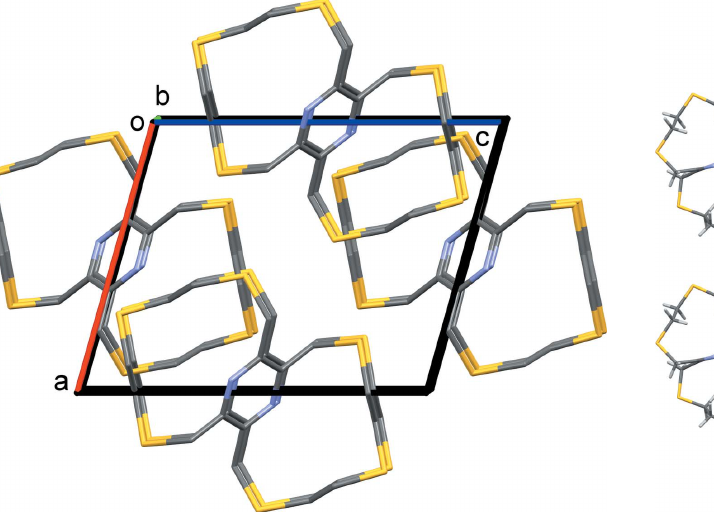
Figure 3 A view along the b axis of the crystal packing of I . For clarity, the minor components of the disordered atoms in the chains and the H atoms have been